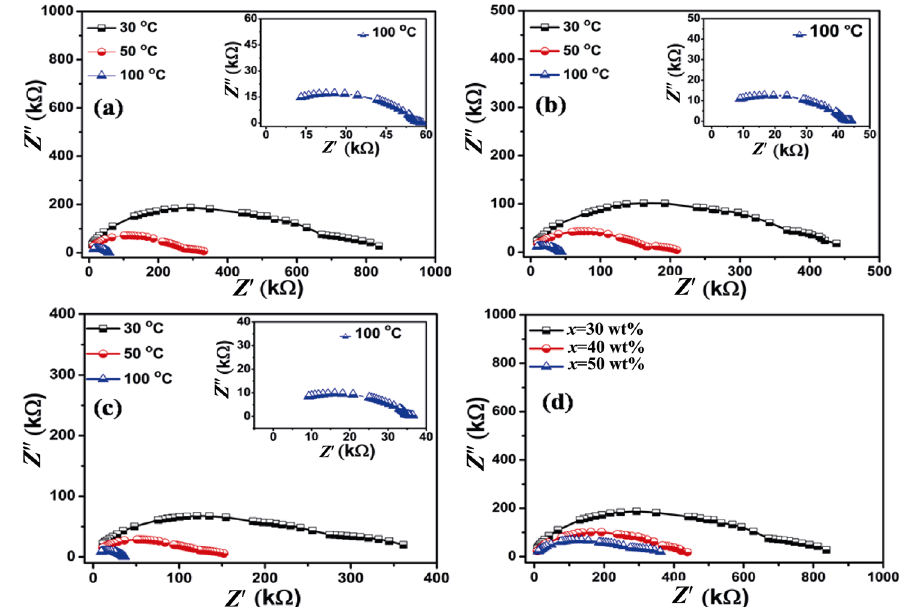
Fig. 6 Complex impedance spectra of (1 ̶ x )KNN–( x )BHF composites: (a) x = 30 wt%, (b) x = 40 wt %, (c) x = 50 wt%, and (d) complex impedance spectra of (1 ̶ x )KNN–( x )BHF ( x = 30, 40, and 50 wt%) composites at room temperature.